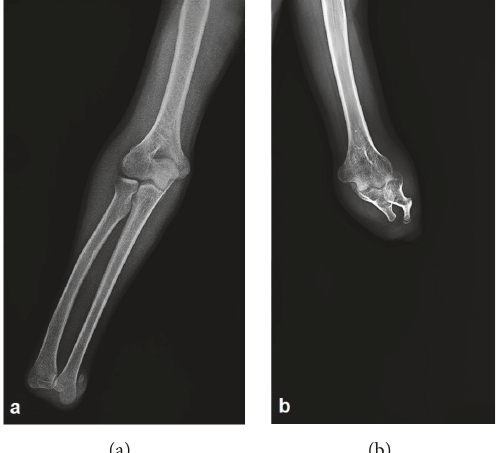
Figure 3: Anteroposterior radiographs of the right (a) and the left (b) arms demonstrating the absence of the right hand with well-developed radius and ulna, and the absence of the left forearm distal to the elbow where there are small radial and ulnar segments participating in the elbow joint. There is a rudimentary bone of about 1 cm in the medial neighborhood of the medial aspect of the right distal ulna.